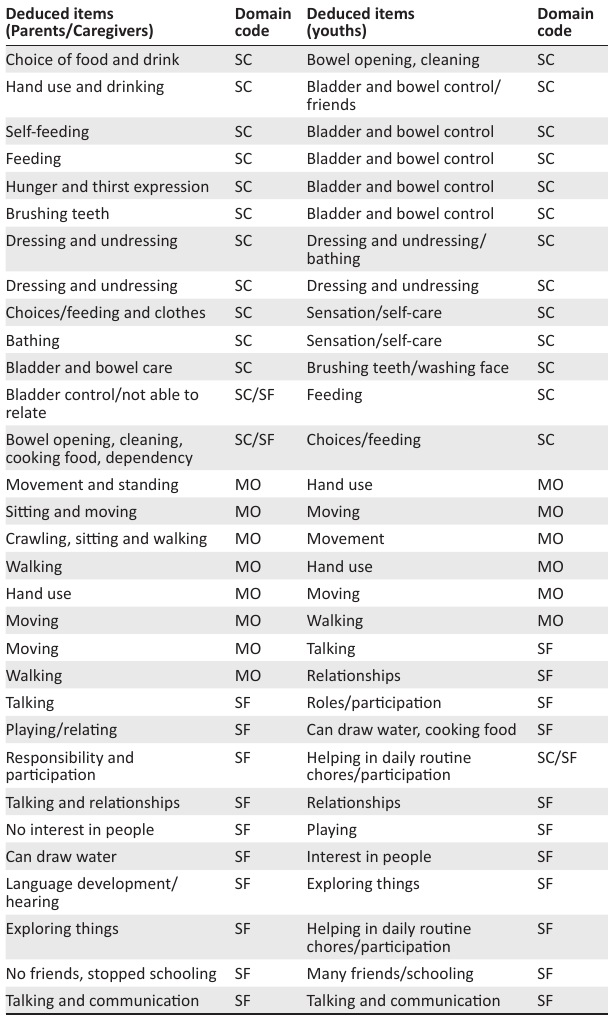
TABLE 5: Pooling of statements from both semi-structured interviews and focus group